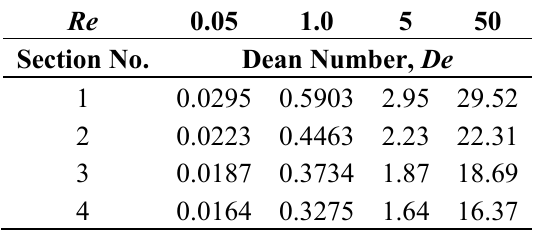
Table 1. Calculated Dean number at spiral channel sections 1 to 4 and Reynolds numbers.